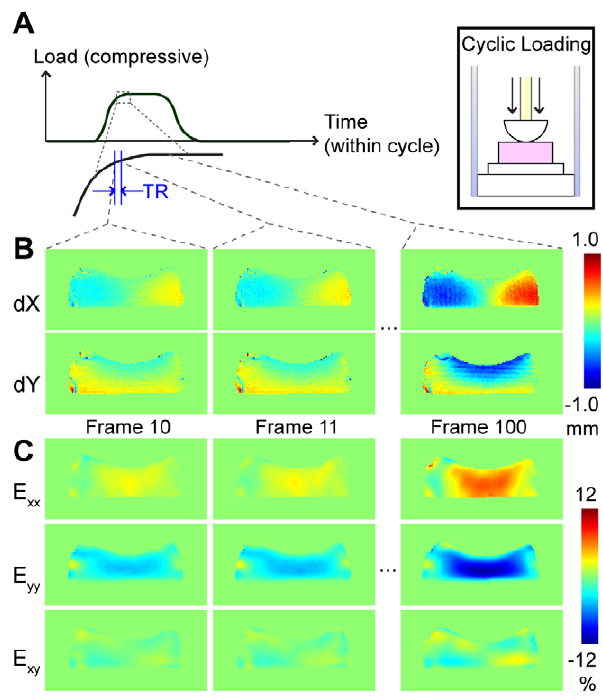
Figure 3. DENSE-FISP of transient mechanical behavior. High temporal resolution displacement-encoded MRI nondestructively mea- sured displacements and strains at a sampling rate of 444 Hz (TR=2.25 ms). Cyclic compression was applied to a silicone gel using a rounded indenter, and a 100-frame cine DENSE-FISP image was acquired during a transient portion of the loading curve ( A ). In-plane displacements ( B ) and strains ( C ) shown for frame numbers 10, 11, and 100 demonstrate that DENSE-FISP is capable of measuring transient mechanical behaviors at high temporal resolution ( B ).